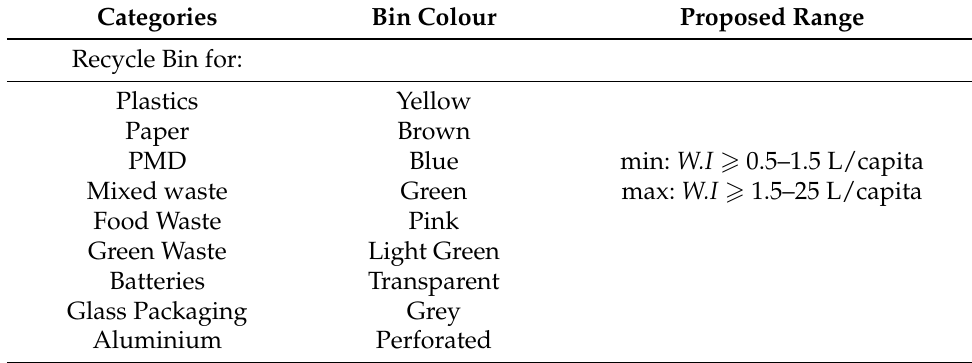
Table 5. Types of recycling bins proposed range per population density and